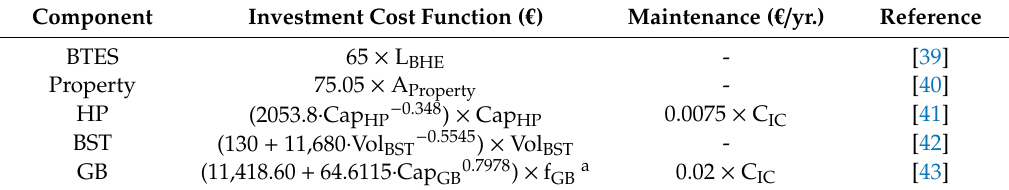
Table 2. Cost function of di ff erent components.